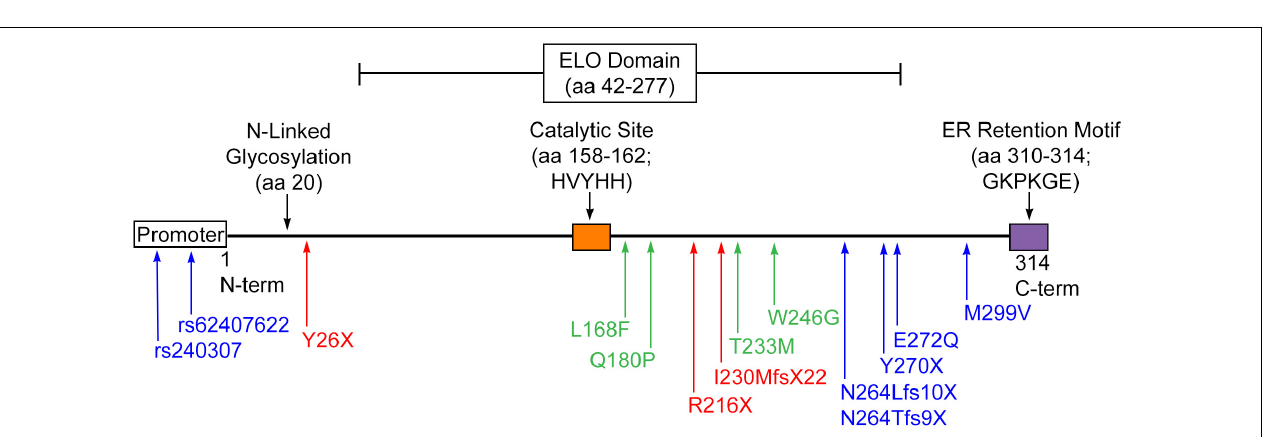
FIGURE 6 | Disease-causing mutations in ELOVL4. STGD3-causing mutations (blue) result in early truncation of ELOVL4 and the loss of the C-terminal ER retention motif or, in the case of the promoter mutations, severely suppress ELOVL4 expression. SCA34-causing mutations (green) result in amino acid substitutions but still produce a full-length protein. ELOVL4 Neuro-ichthyosis-causing mutations (red) cause very early termination of the protein that would truncate substantial portions of transmembrane domains in either the 5-transmembrane or 7-transmembrane models of ELOVL4 topology in addition to deleting the ER retention